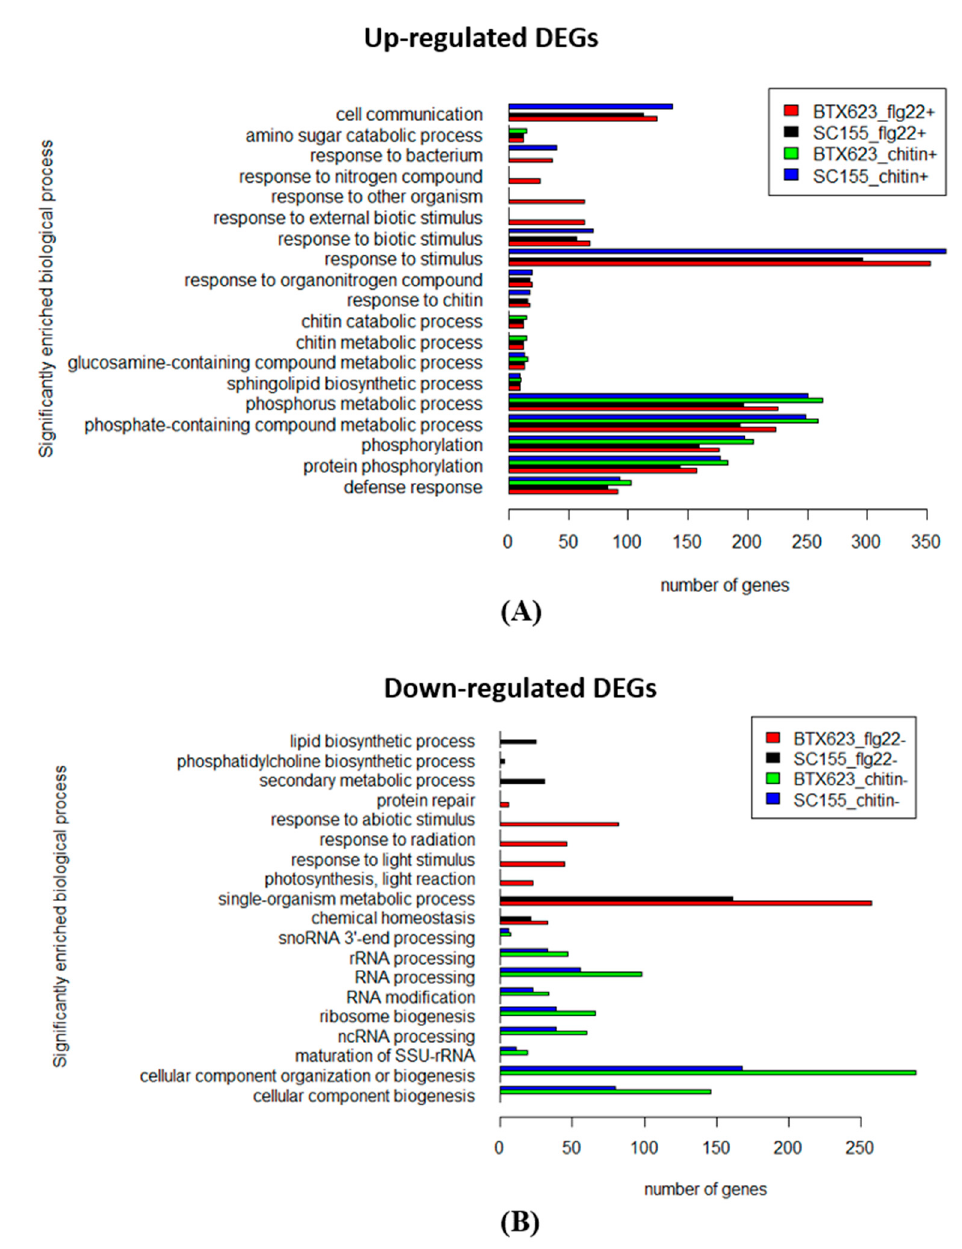
Figure 8. Top GO terms of DEGs in flg22 or chitin treated BTx623 and SC155-14E. Enriched GO terms of detected DEGs were classified into functional categories of biological processes using PlantRegMap platform ( A ) Up-regulated DEGs. ( B ) Down-regulated DEGs.